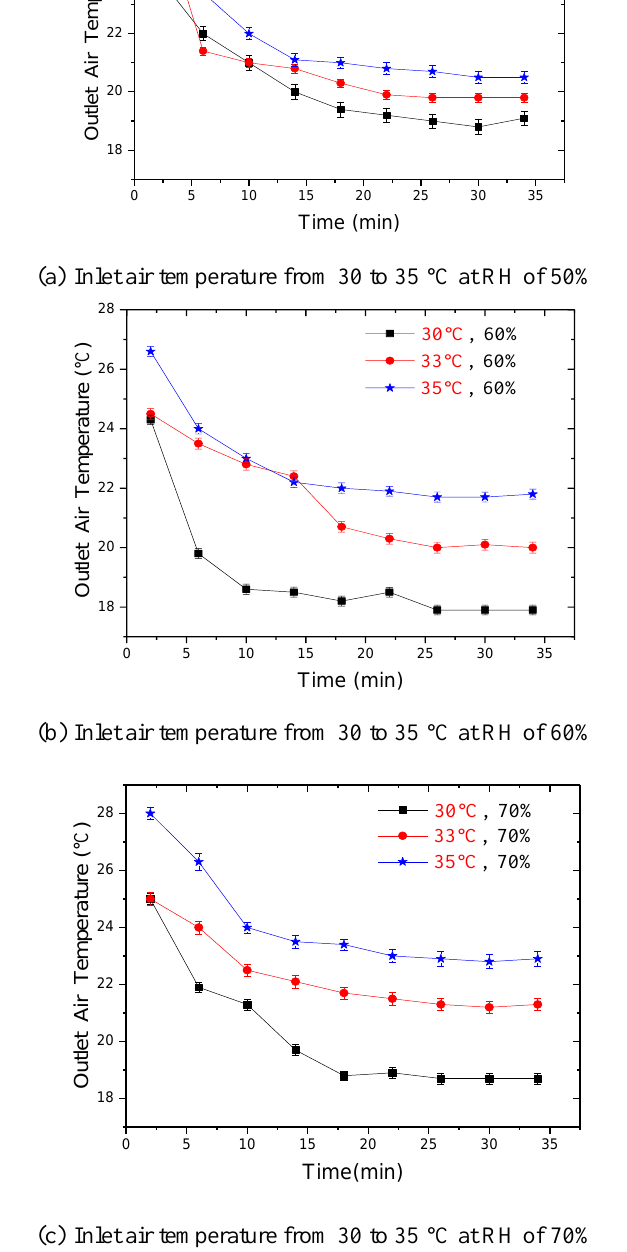
Figure 5. Variation of the air temperature at the outlet of the minichannel heat exchanger (MHE) under di ff erent air inlet temperatures ( T a-in ) and relative humidity